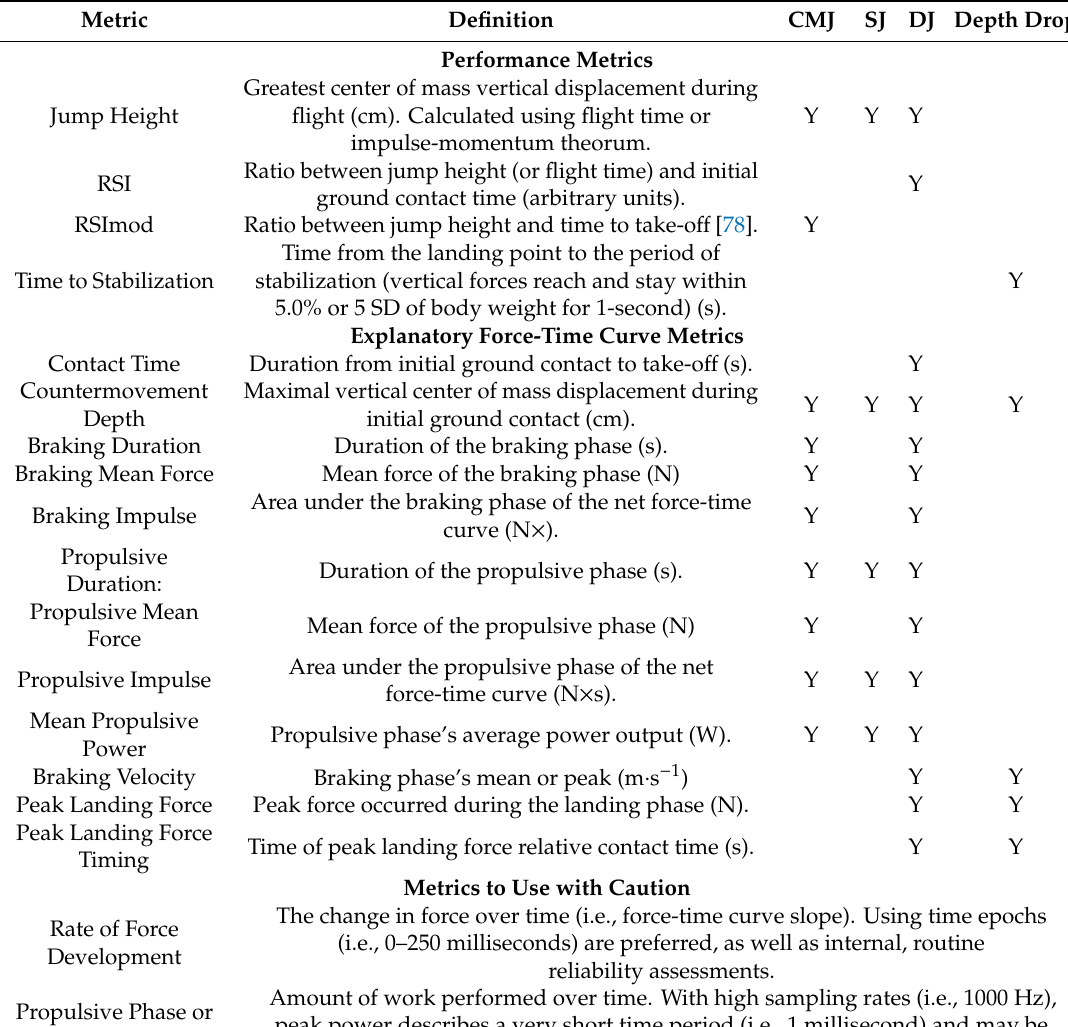
Table 2. Definitions of Force-Time Metrics and Related